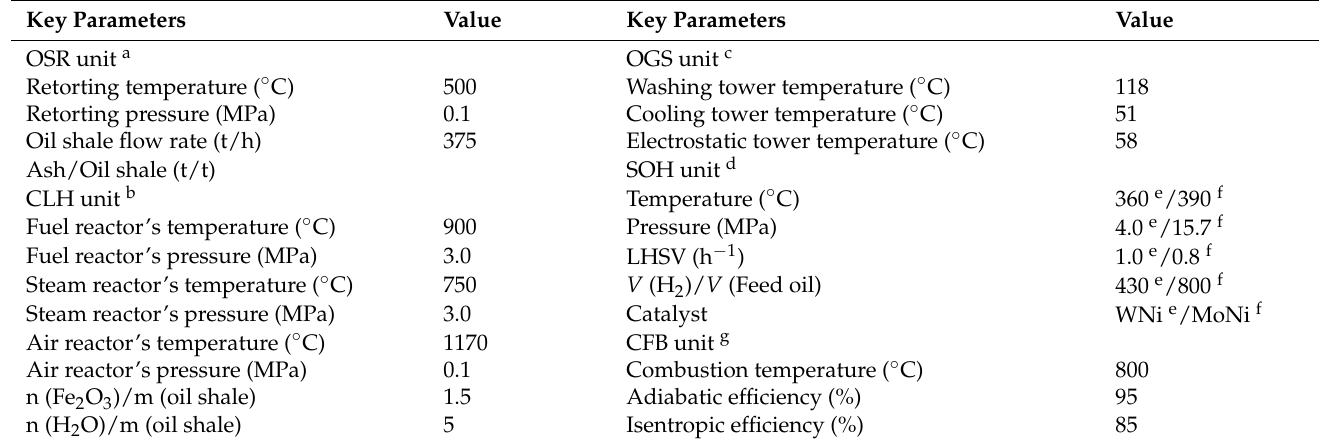
Table 2. Key unit operation parameters of the CLeSTL process.